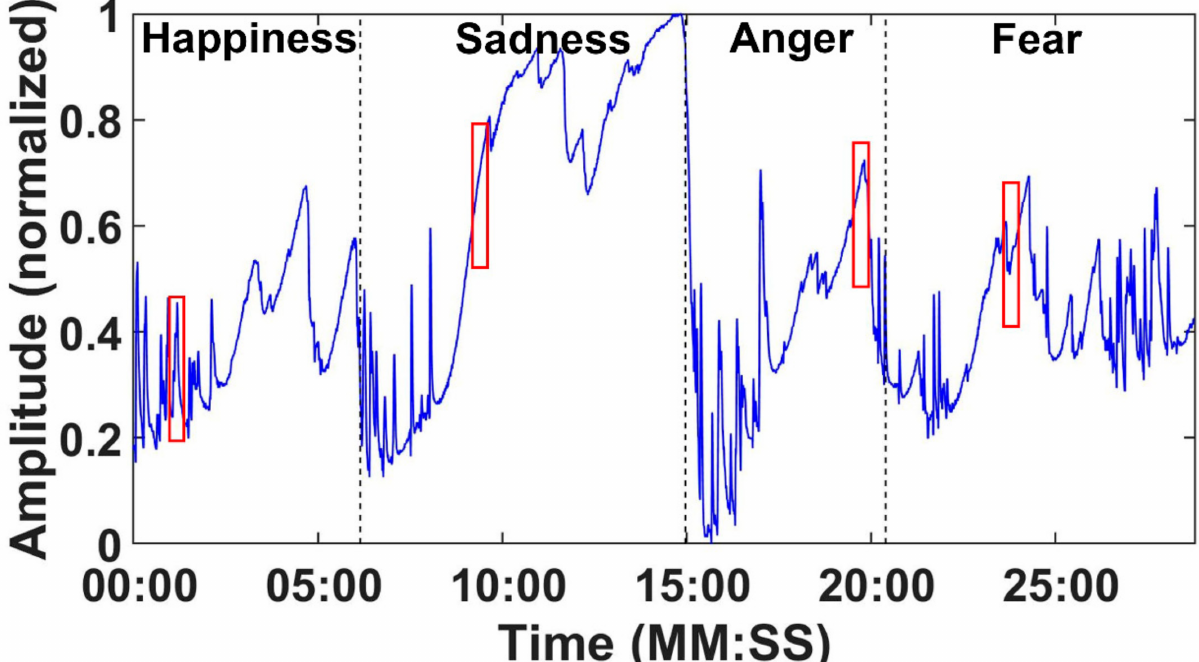
Figure 7. The whole SP recording from subject 5 during video viewing after data preprocessing. In much of the related research, emotion samples are segmented by fixed